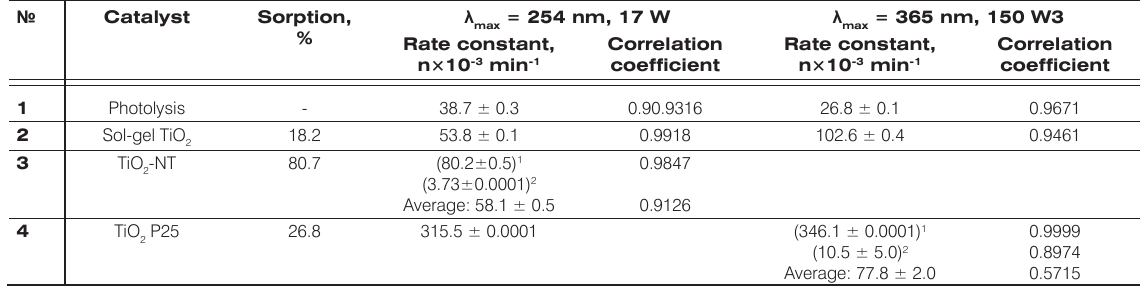
Table 5. Sorption ability and apparent degradation rate constants obtained during the photolytic/photocatalytic oxidation of model pollutant over various catalysts.